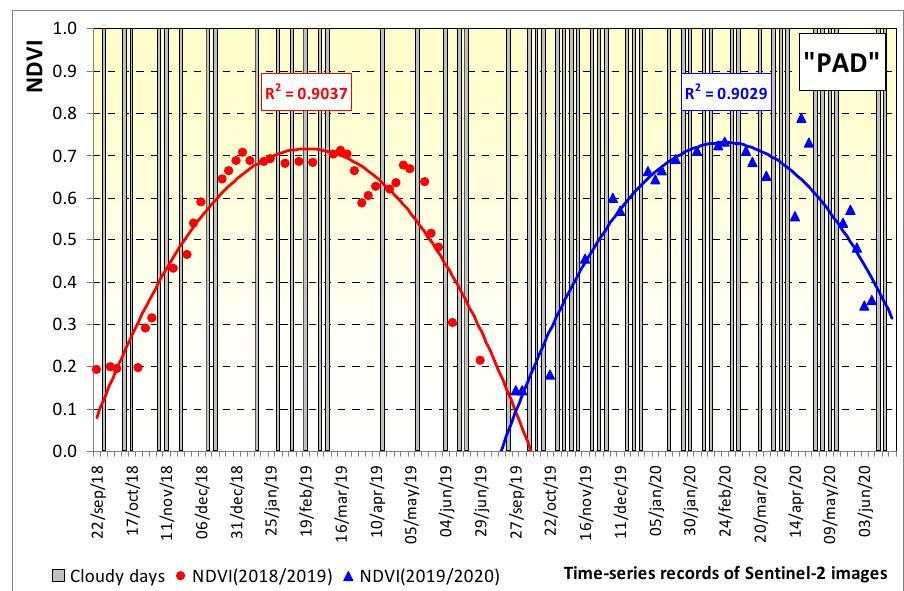
Figure 13. NDVI time-series records obtained in 2018/2019 and 2019/2020 in “PAD” field.